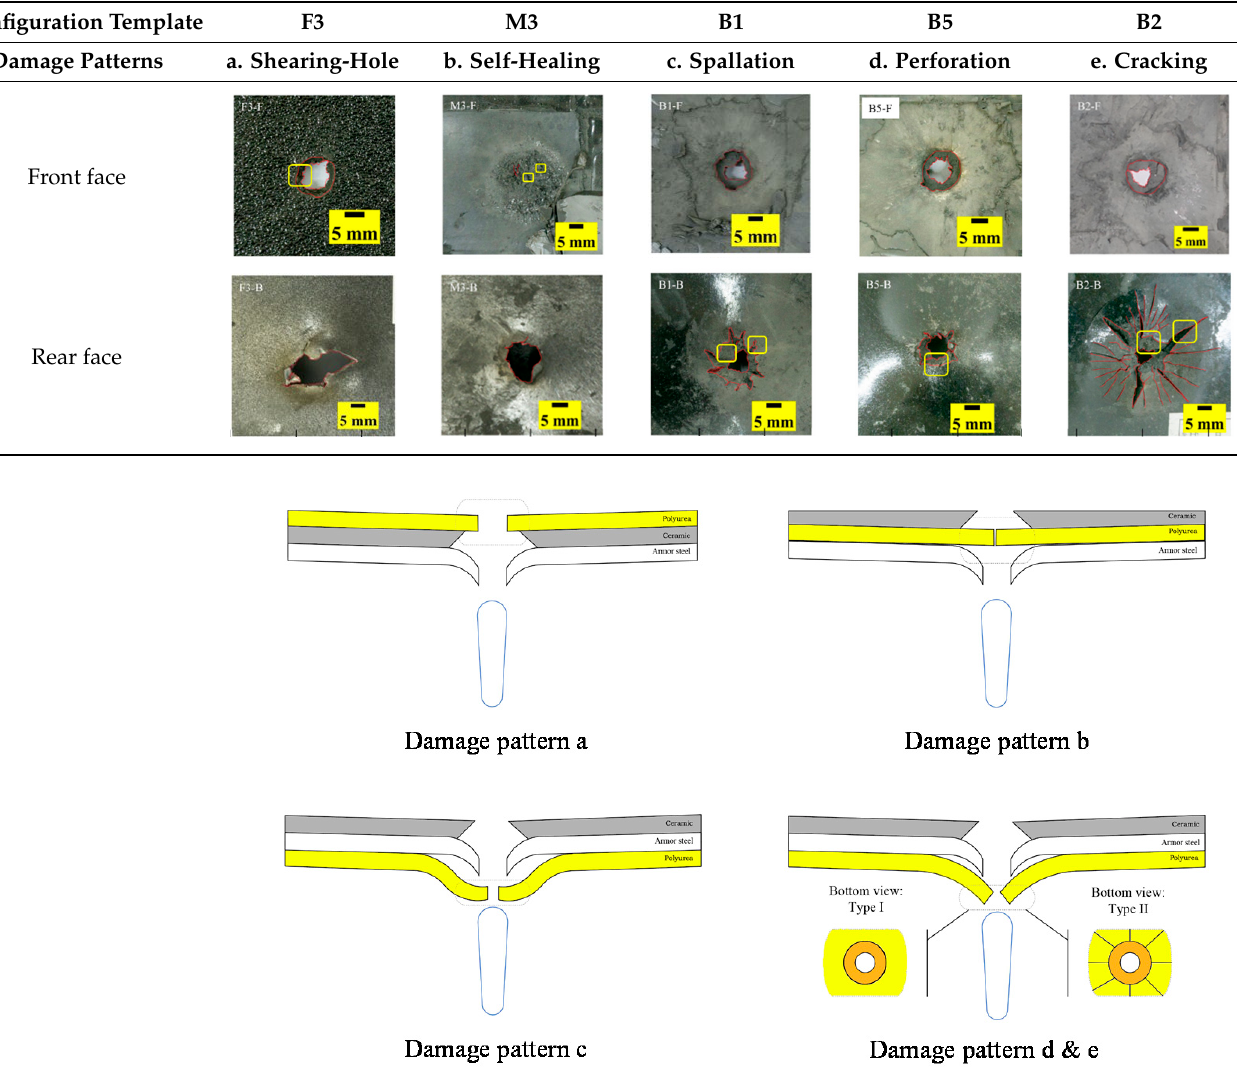
Figure 6. Damage patterns of the targets.